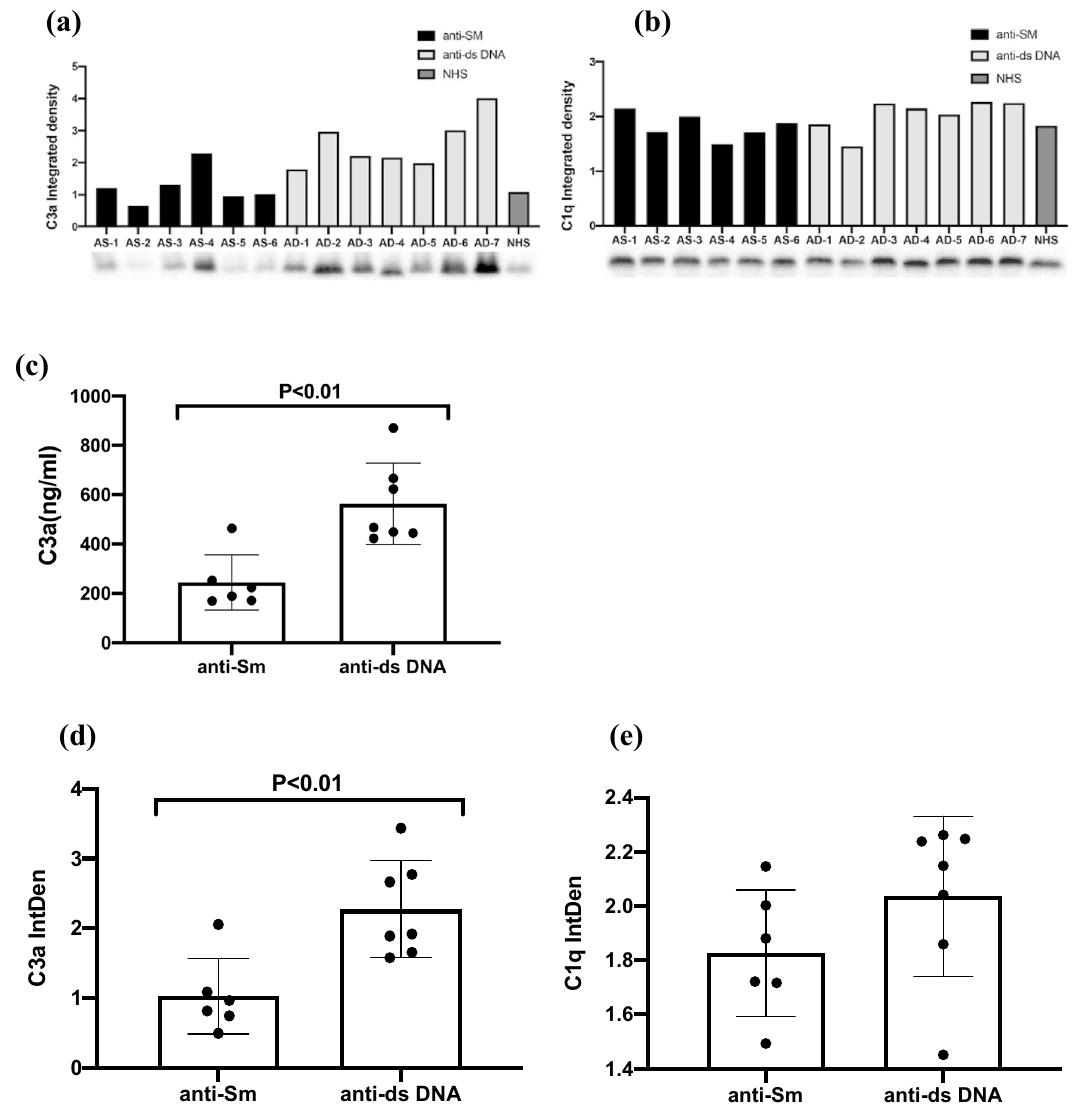
Figure 1. Serum C3a levels in SLE patients positive for anti-Sm and anti-dsDNA autoantibodies. ( a , b ) 6 SLE patients positive for anti-Sm autoantibodies, and 7 SLE patients positive for anti-dsDNA autoantibodies, C3a and Cq1 levels were measured via Western blotting. ( c ) Serum samples from donors collected as in ( a ) were used to assess C3a levels via ELISA based on provided directions. ( d ) C3a levels were significantly higher in SLE patients positive for anti-dsDNA as compared to anti-Sm+ patients ( P < 0.01). ( e ) No significant differences in serum C1q levels were observed between groups. Data were compared via Student’s t-tests, with dots corresponding to individual